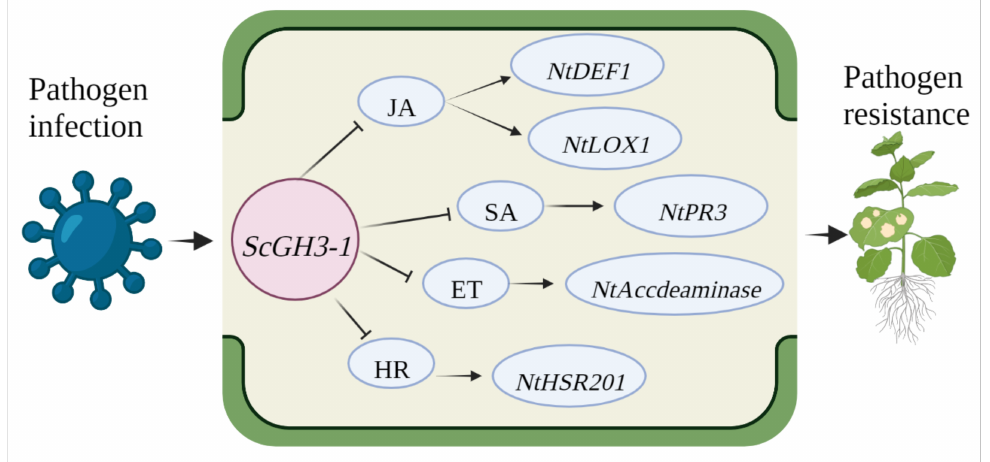
Figure 12. A proposed model for ScGH3-1 -mediated regulation in the response of N. benthamiana to pathogen infection. ET, ethylene synthesis; JA, jasmonic acid; SA, salicylic acid; NtLOX1 , lipoxygenase 1; NtDEF1 , defenseless 1; NtPR3 , pathogenesis-related genes; NtAccdeaminase , ACC deaminase gene; NtHSR201 , hypersensitivity-related